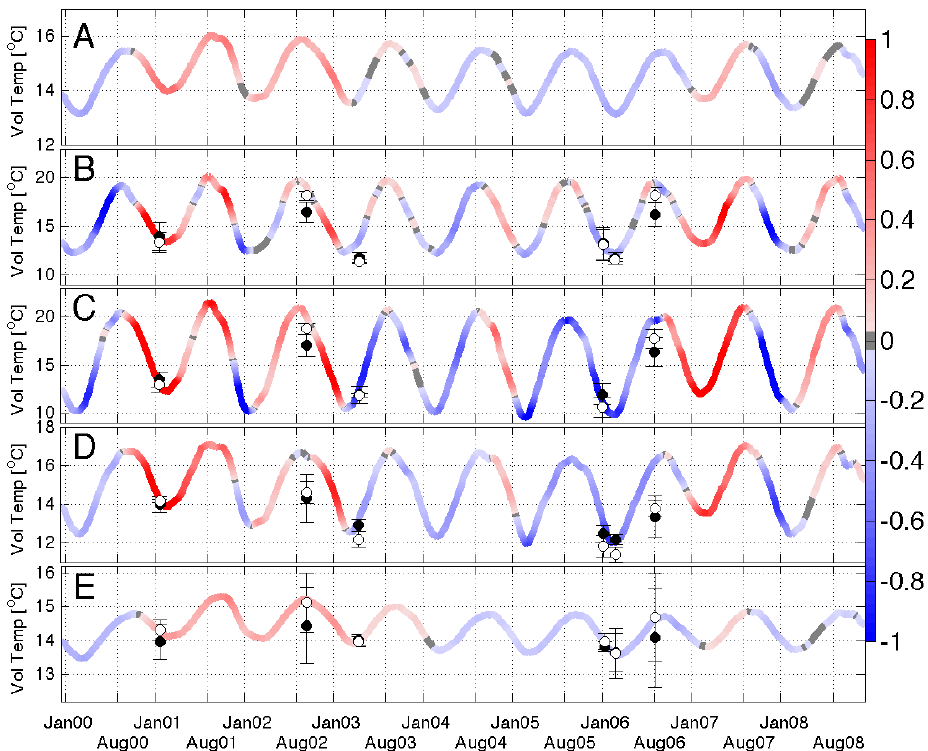
Fig. 6 Monthly time series of volume-averaged temperature, units are o C. Colour indicates monthly anomaly values. A: whole Adriatic Sea; B: WACC region; C: Northern Adriatic Region; D: Middle Adriatic Region; E: Southern Adriatic Region. In panels B-C-D and E dots indicate the vertically- and spatially-averaged values of observations (black dots) and model results (white dots). Dates of the sampling are listed in Table 1; positions of the sampling are displayed in Fig. 1. The model results were sampled in the same position and at the same time as the observation before averaging.